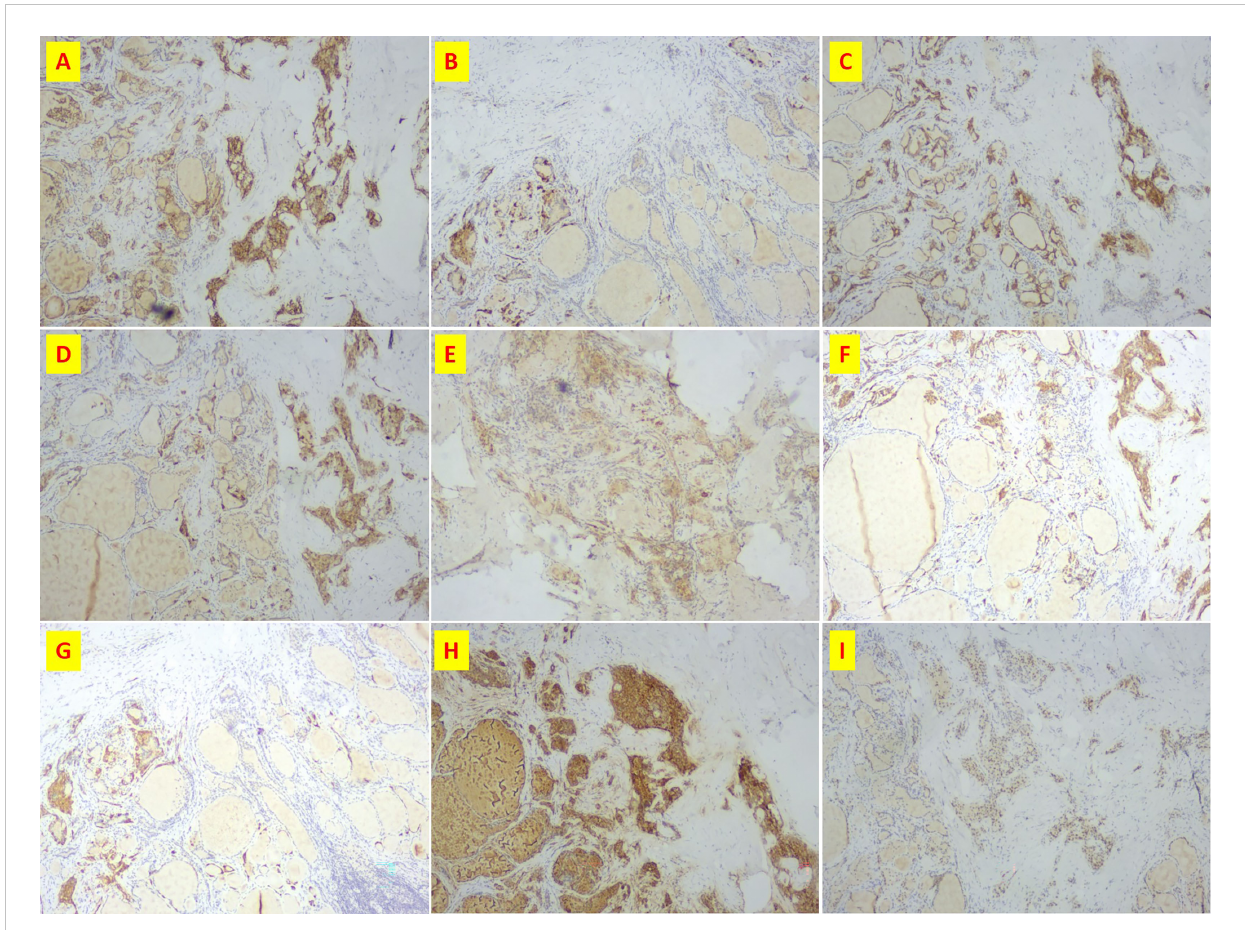
FIGURE 3 Immunohistochemistry of patient n.2 that MTC and PTC was in the same lesion. (A) CD56(+); (B) CgA(+); (C) CK19(+); (D) CT(+); (E) Galectin3(+); (F) Syn(+); (G) Syn(+); (H) Tg(+); (I)